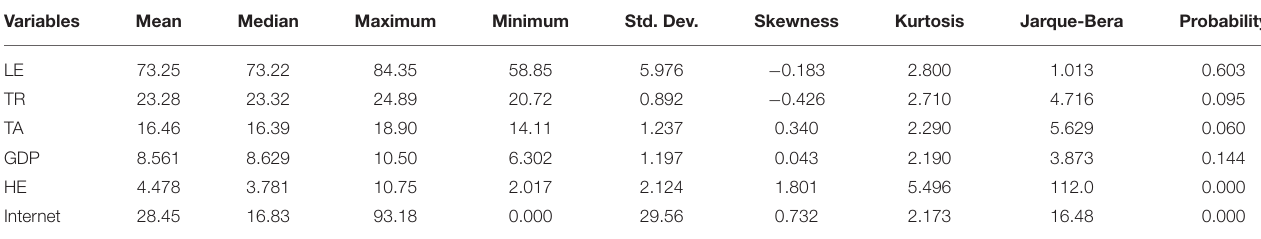
TABLE 2 | Data description.